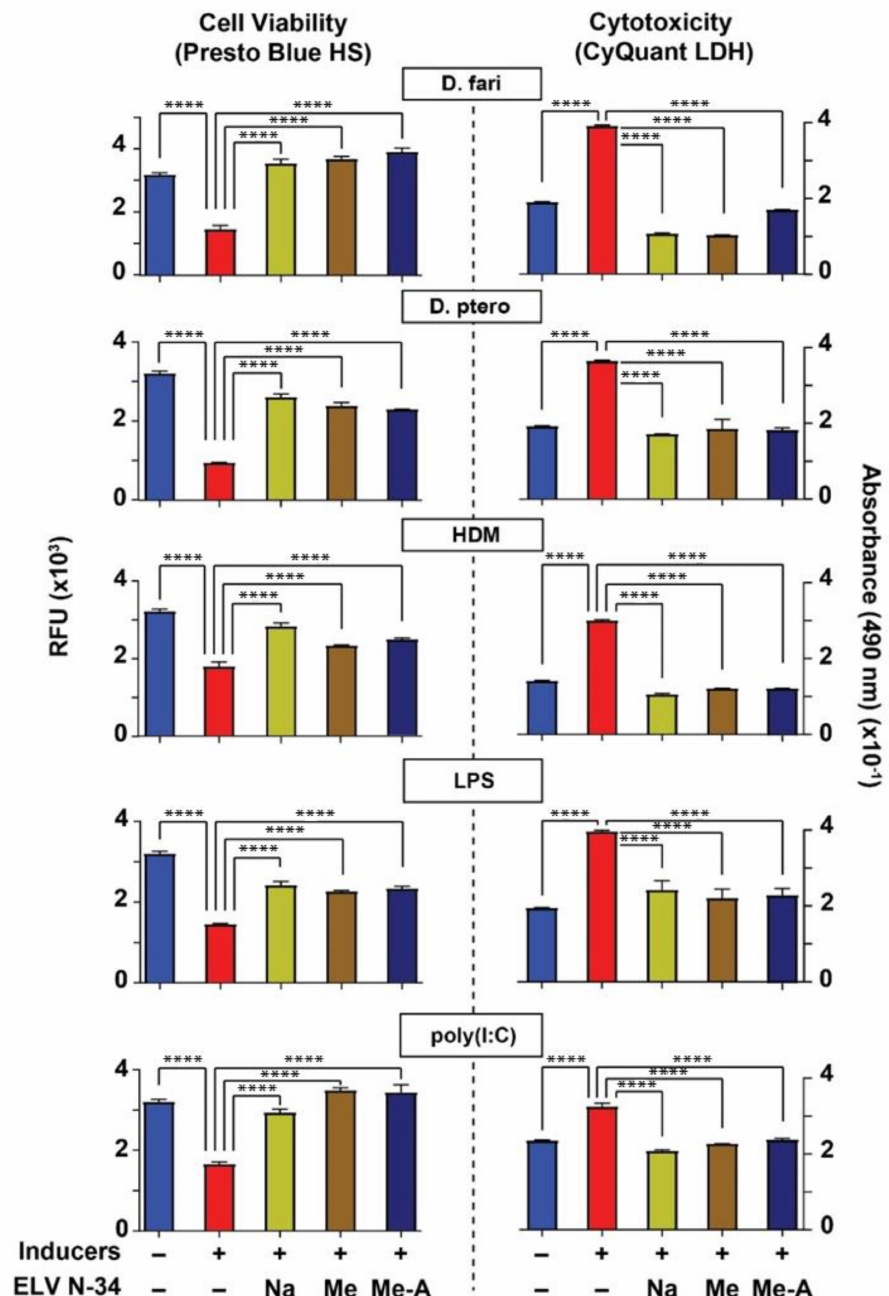
Figure 2. ELVN-34 protect HNEpC from cytotoxicity induced by HDM. Cell viability assay using Presto Blue HS kit (left panel) indicated that HNEpC treated with ELVN-34 (500 nM) were protected from cytotoxicity and cell death induced by Dermatophagoides farinae , Dermatophagoides pteronyssinus , and ( D. farinae + D. pteronyssinus ) (HDM), or LPS or poly(I:C) (30 µ g/mL). Cytotoxicity assay using CyQuant LDH (right panel) shows that ELVN-34 (500 nM) elicit potent cytoprotection to HNEpC when challenged by the inducers. The results showed the averages of three independent experiments (**** p <